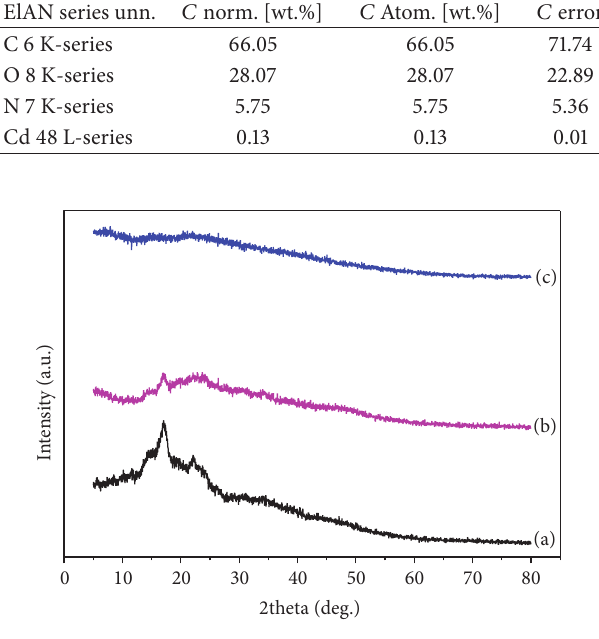
Table 2: Quantitative data of EDX measurement for cross-linked starch xanthate after adsorbed Cd 2+ . ElAN series unn.